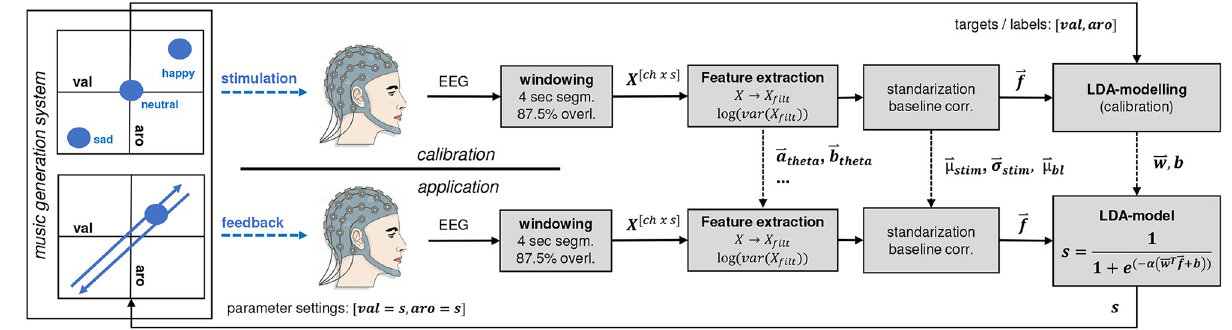
Fig 3. BCI architecture. Signal processing and information flow during calibration (top row) and online application (bottom row) of the system. Note, the dual use of the automatic music generation system in both cases for providing either open-loop stimulation (calibration) or closed-loop feedback (application). The black dashed lines indicate model-specific parameters (filter parameters, standardization and baseline parameters, and classifier parameters) that were obtained during calibration, and utilized during online application.